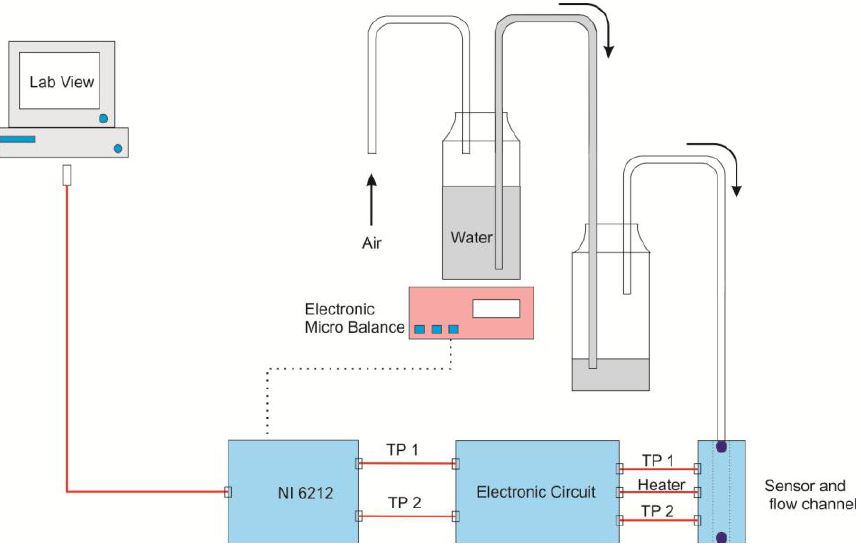
Figure 3. Setup for generating very small flow rates. The flow is identified by measuring the water flow rate between two closed